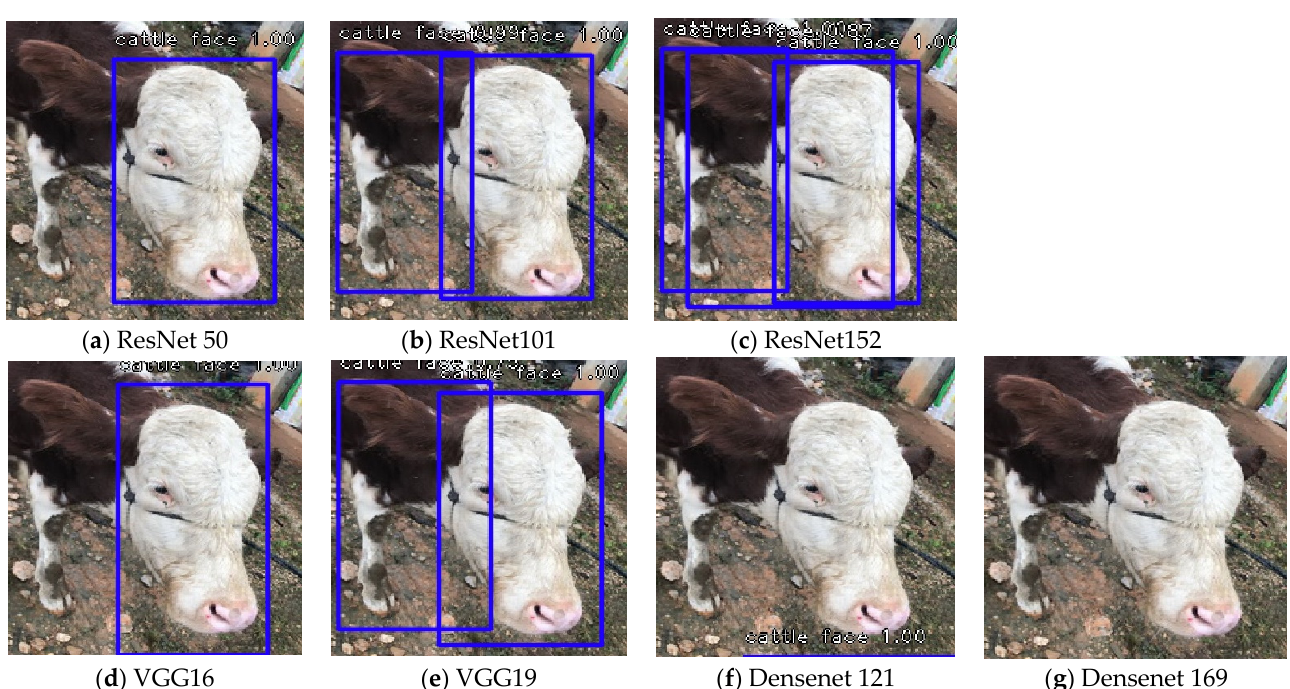
Figure 6. Comparisons of cattle face detection processed by seven different backbones.